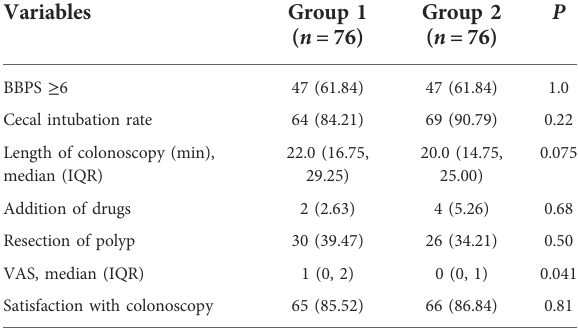
TABLE 2 Comparison of the clinical outcome of two groups.